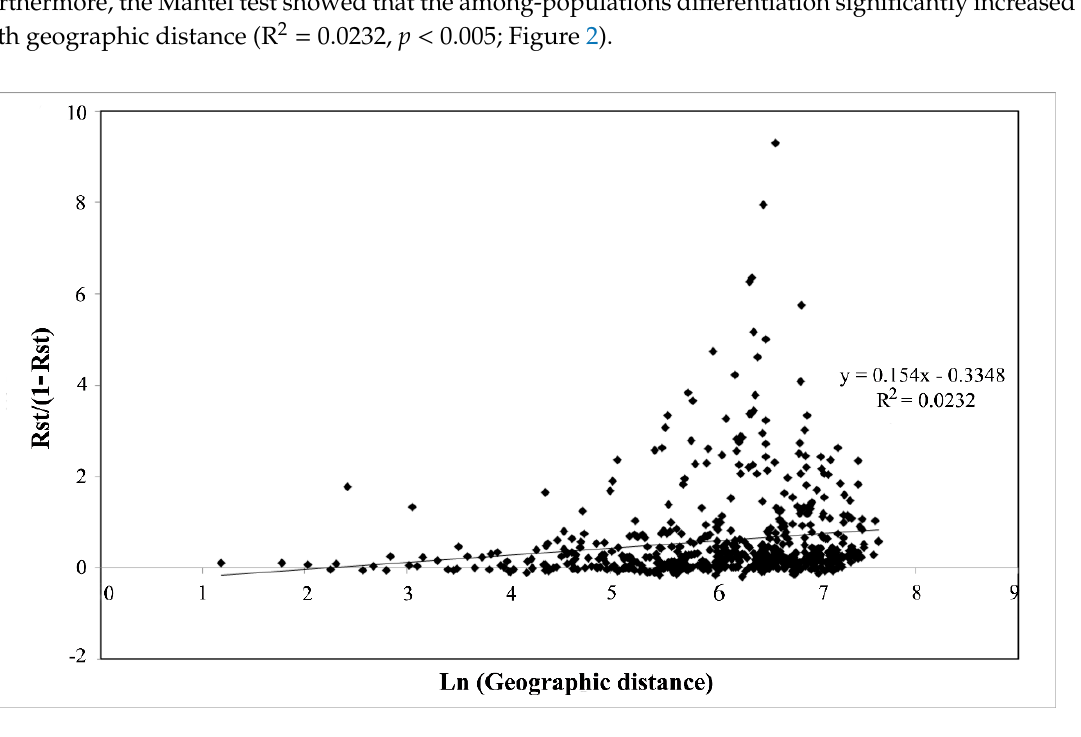
Figure 2. Mantel correlation between the genetic and geographic distances.